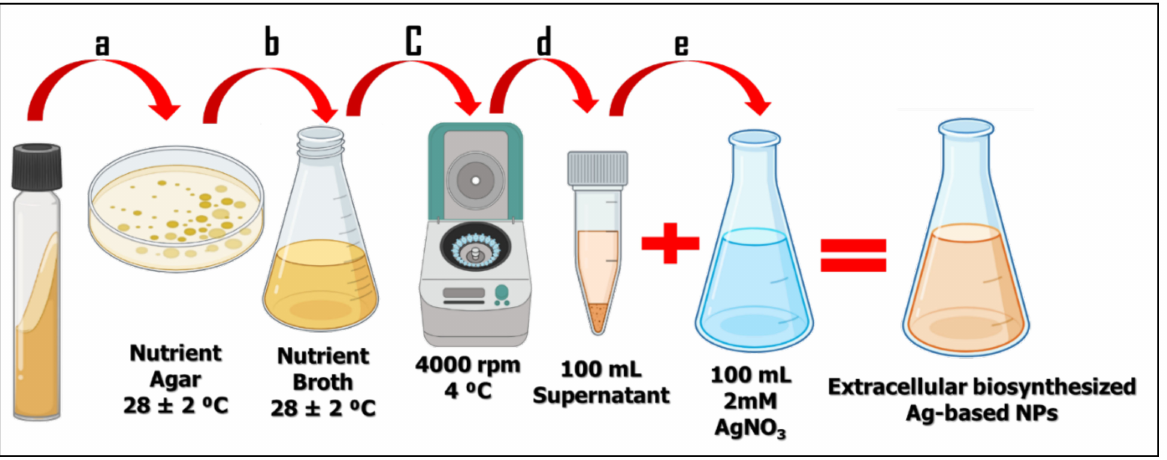
Figure 1. The entire process of the extracellular biosynthesis of Ag-based NPs utilizing sustainable bio-waste including all steps ( a – e